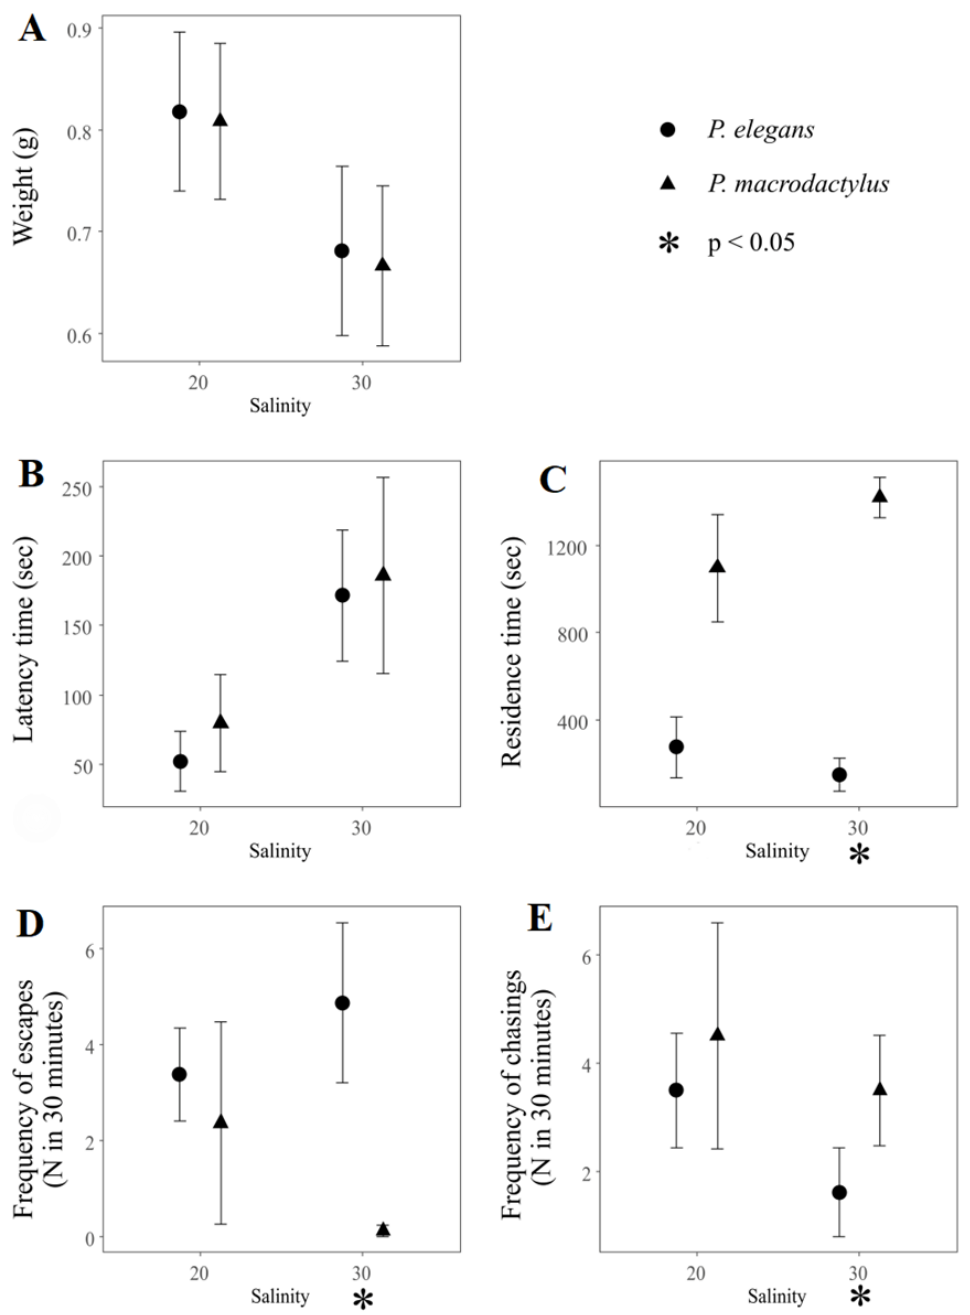
Figure 2. Mean values ( ± S.E.) of ( A ) the weights in grams, ( B ) the latency time in seconds, ( C ) the residence time in seconds, ( D ) the frequency of escapes expressed in number of events in 30 min and ( E ) the frequency of chasing expressed in number of events in 30 min. The asterisks indicate the significant differences according to the t-test ( p -values < 0.05).